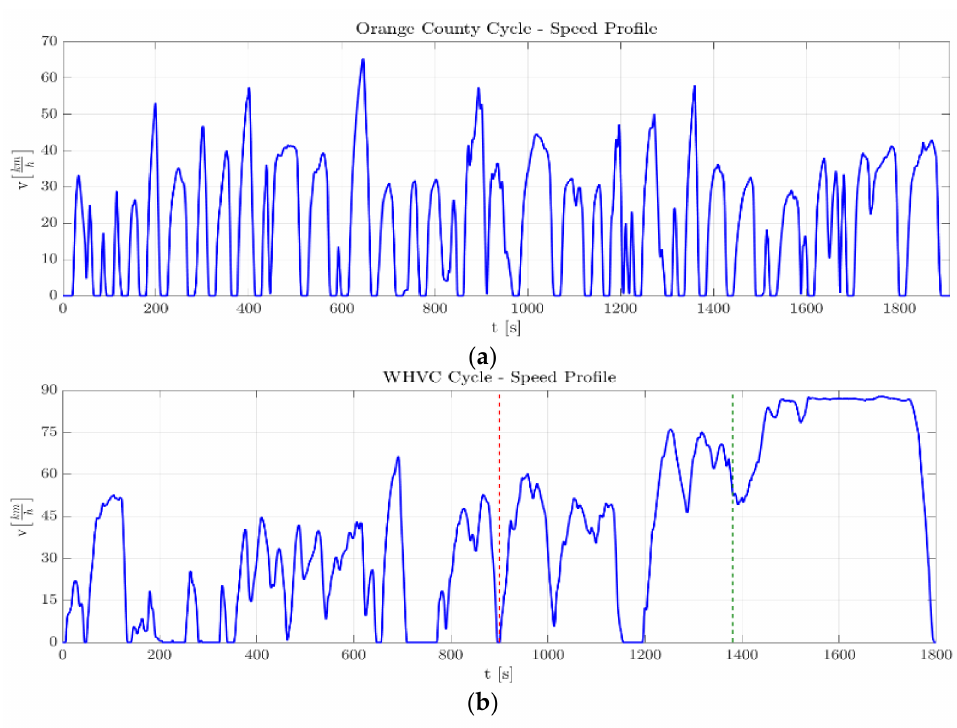
Figure 13. ( a ) Orange County cycle—speed profile; ( b ) WHVC—speed